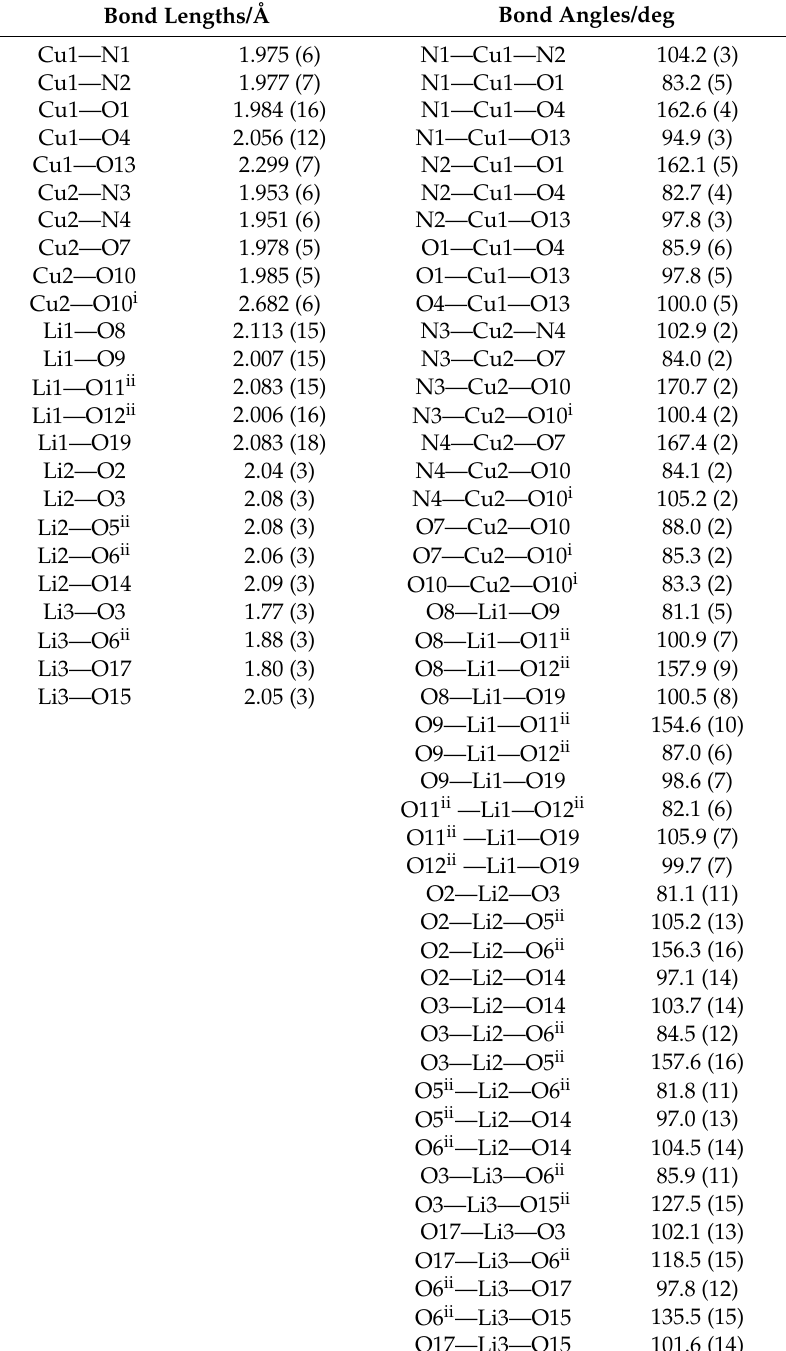
Table 2. Main Bond Lengths (Å) and Angles (deg) for 1 a